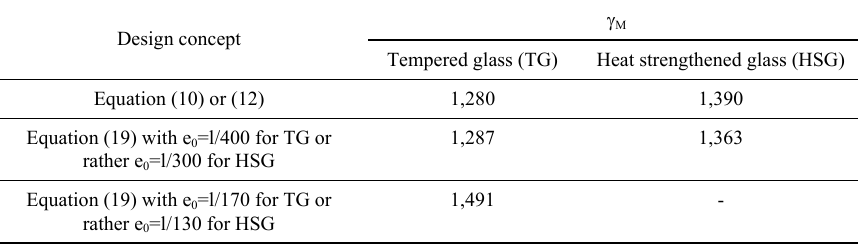
Table 2: Partial safety factors γ M